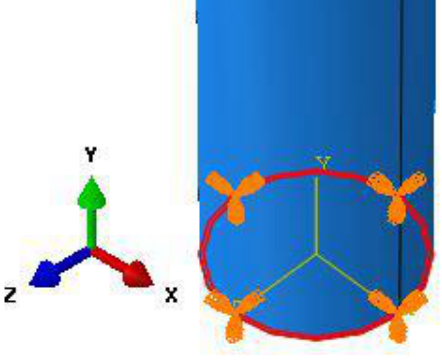
Figure 2. Boundary Figure 2. Boundary conditions. Figure 2. Boundary conditions.